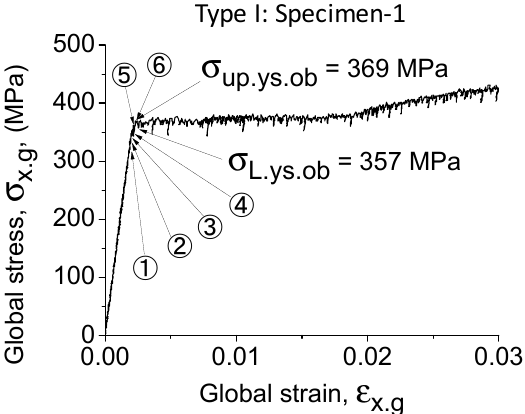
Figure 4. Experimental stress-strain curve. The global nominal strain was measured using an extensometer with a gauge length (GL) of 30 mm.